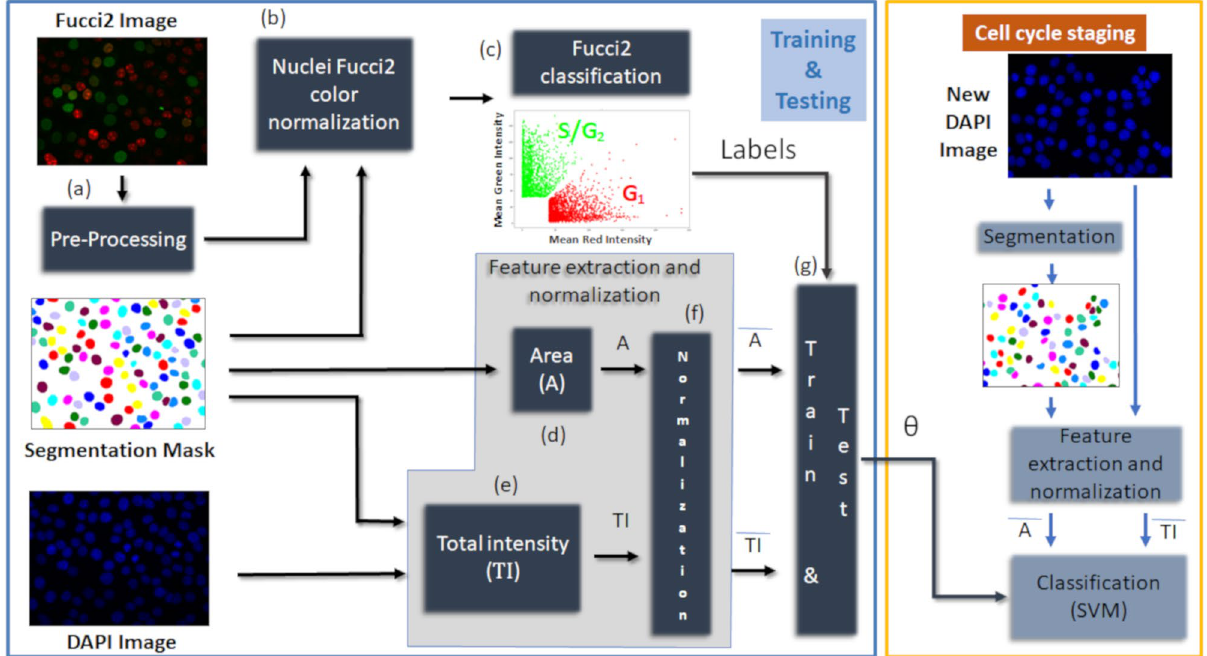
Figure 1. Overall pipeline to train and test the SVM for interphase cell cycle staging. The processing pipeline involves the analysis of DAPI and Fucci2 images, which are required to train and test the classifier (blue box, a–g ). The final single cell cycle staging procedure uses the classifier parameters, obtained in the training phase, to identify the cell cycle phase of new DAPI images (yellow box); SVM support vector machine, Fucci fluorescent ubiquitination-based cell cycle